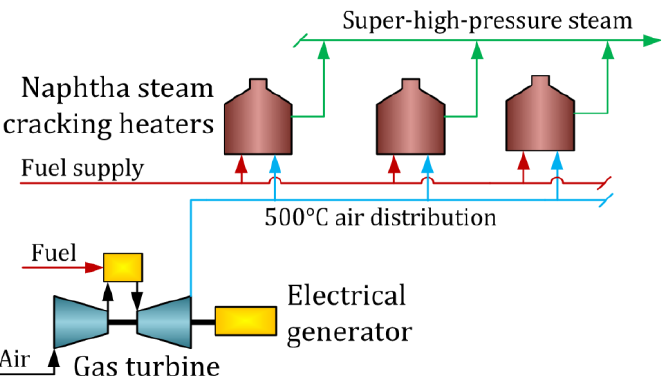
Figure 2. Cracking heater/gas turbine integration in an ethylene plant, adopted from [12].